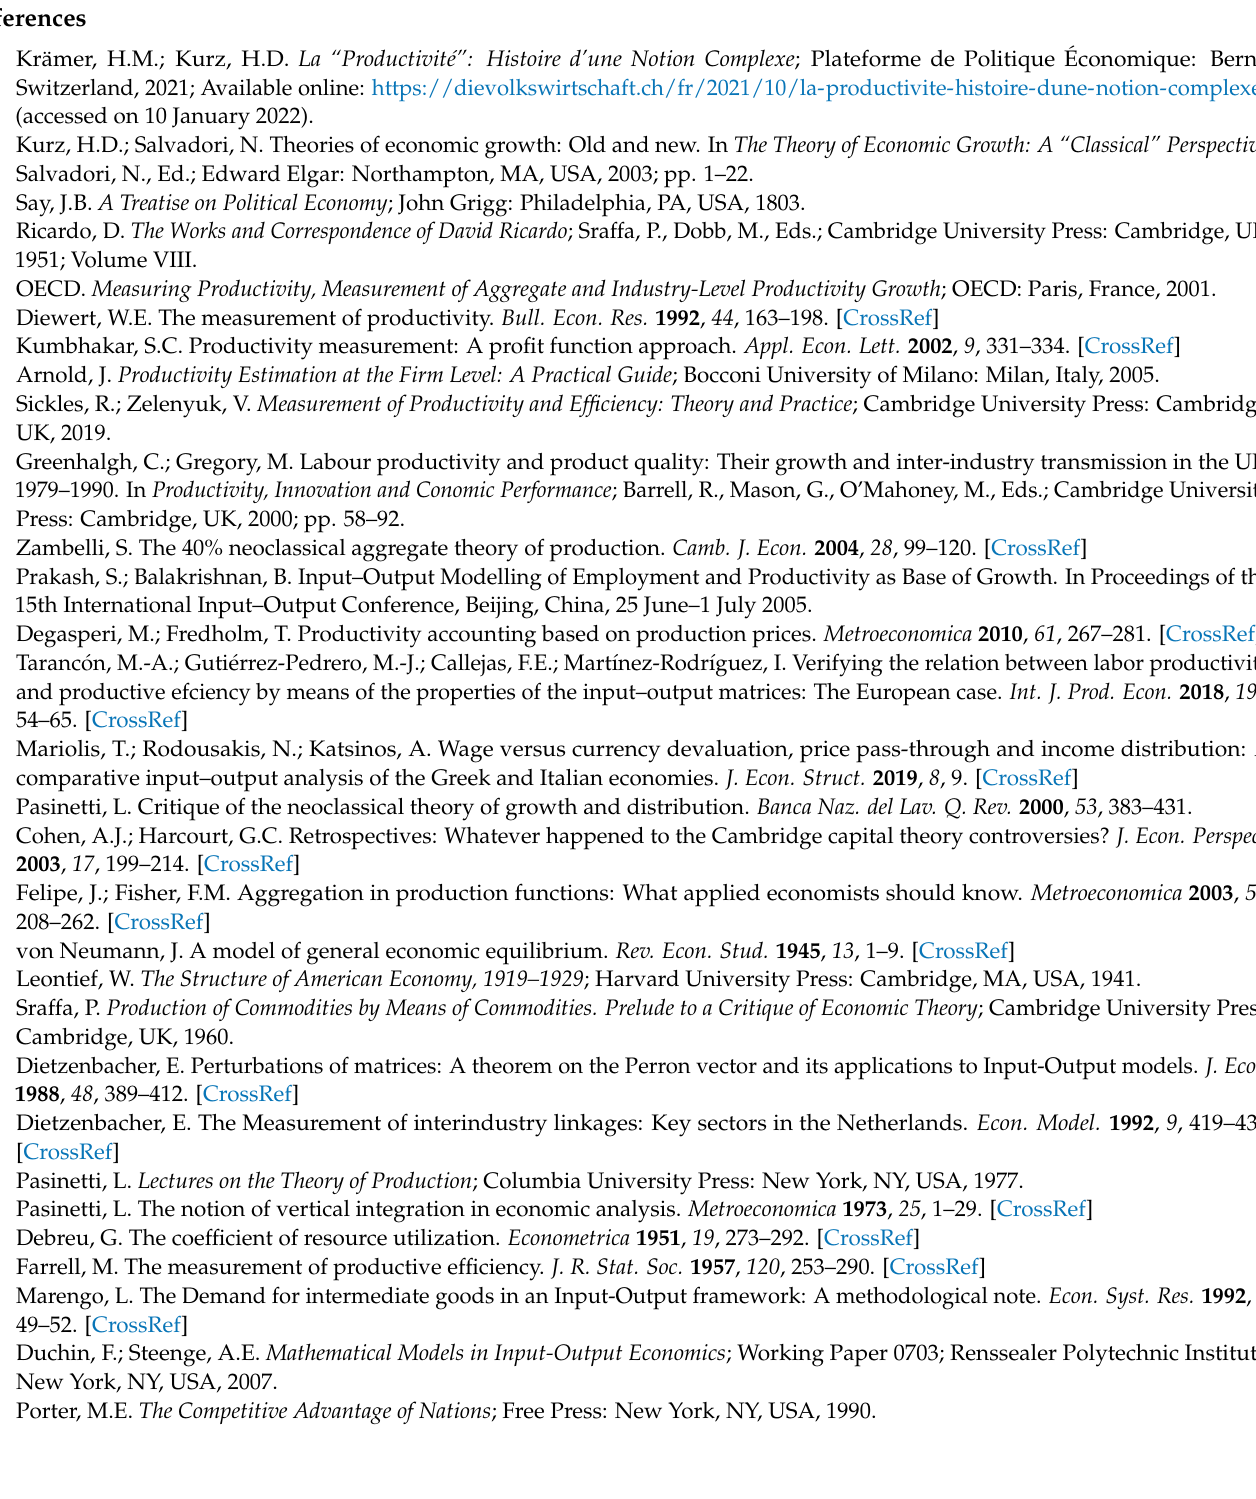
Figure A1. The modulus of the eigenvalues of the input-output coefficients matrix of the 38 OECD economies.